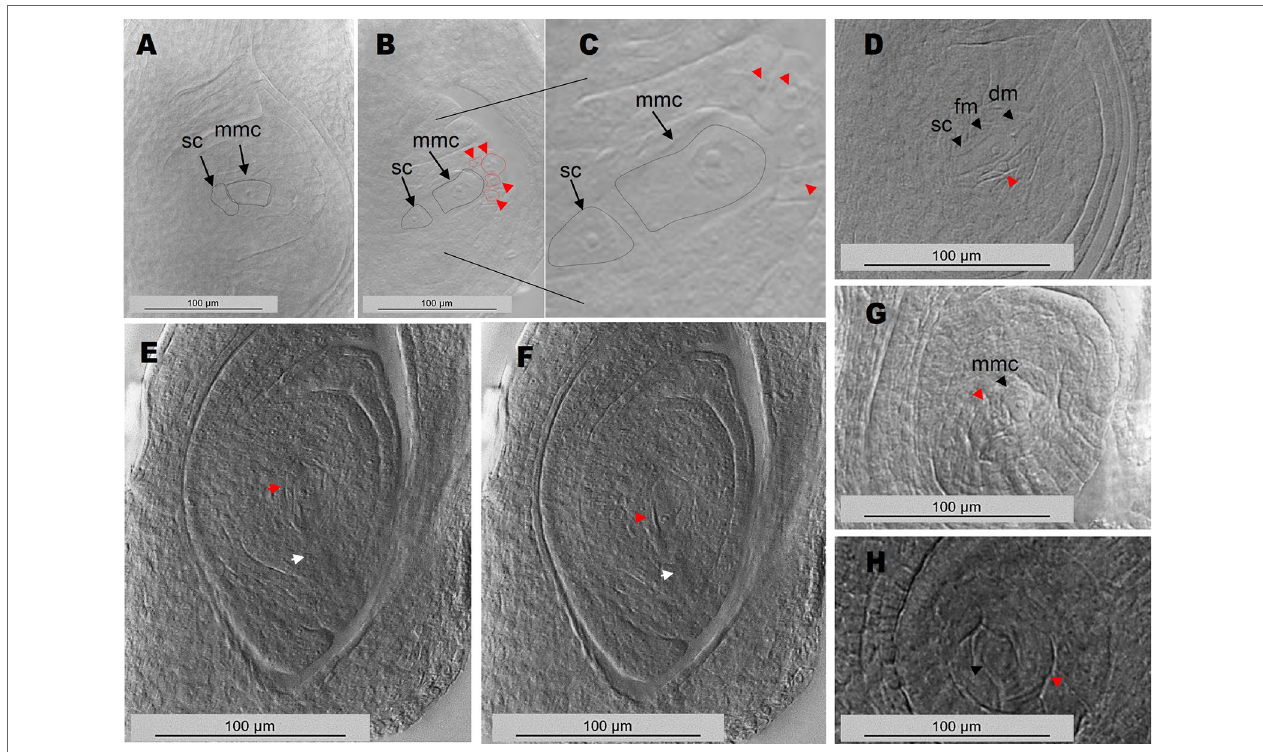
FIGUre 4 | Ovule early developmental stages reveal MMCs and MMC-derived meiotic figures surrounded by cells with enlarged nuclei. (A) wild type sexual ovule with a MMC cell and a typical basal stack cell. (B) E2.9 antisense transgenic plant ovule showing the MMC, the stack cell and several enlarged nuclei on top (red arrows/red dotted lines). (c) same image as in (B) , with higher magnification. (D) E2.9 antisense transgenic plant ovule with a stack cell, a functional megaspore, degenerating megaspores and an adjacent cell with enlarged nucleus (red arrow). (e , F) adjacent planes of an ovule containing a two-nucleate gametophyte (fg2) or alternatively a functional megaspore accompanied by a cell with an enlarged nucleus (red arrows). Degenerating megaspores, which should be present at this developmental stage, are absent (the site where degenerating megaspores should have appeared was marked with a white arrow). (G) ovule with a megaspore mother cell and a neighbouring cell with enlarged nucleus. (H) ovule with a two-nucleate gametophyte (fg2) and a neighbouring cell with enlarged nucleus. mmc, megaspore mother cell; sc, stack cell; fm, functional megaspore; dm, degenerating